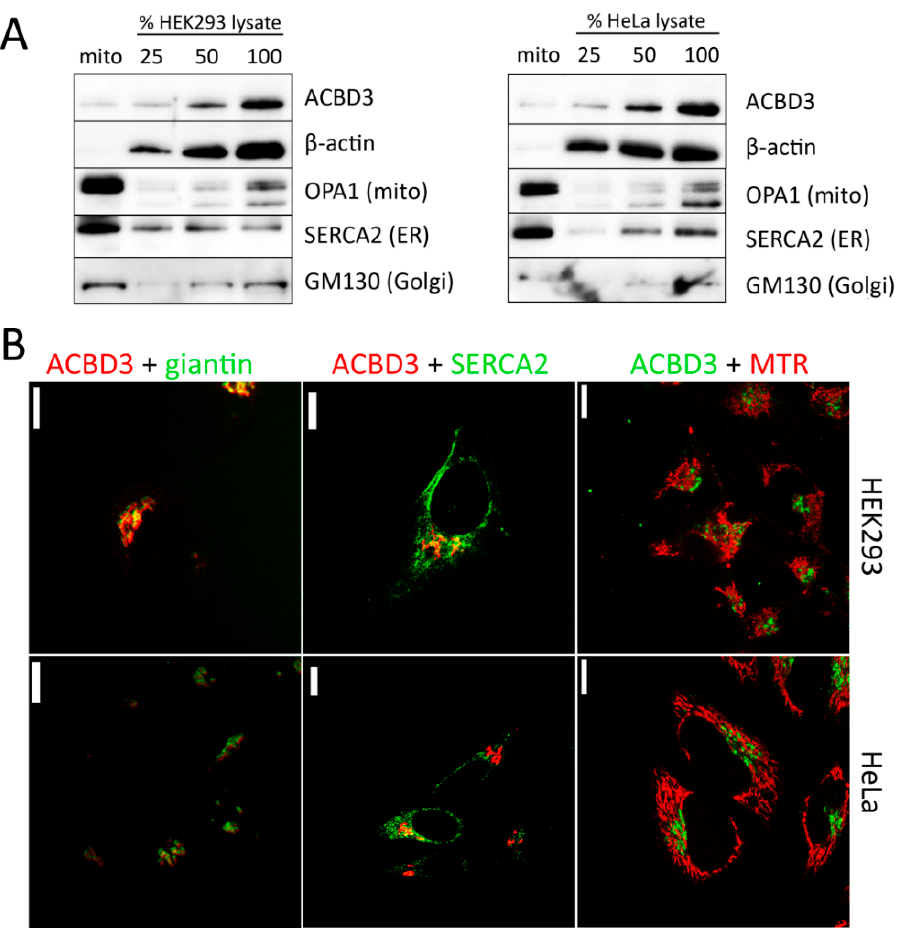
Figure 1. Localization of ACBD3 protein in HEK293 and HeLa WT cells. ( A ) Characterization of mitochondrial fraction and whole cell lysate by SDS-PAGE/WB. The mitochondrial fraction reveals only a slight signal of ACBD3, but the mitochondrial fraction is enriched by endoplasmic reticulum (ER, SERCA2 antibody) and also a slight signal of Golgi (GM130). ( B ) Confocal microscopy of HEK293 WT and HeLa WT cells. The cells were immunolabeled by ACBD3 antibody and, where indicated, by specific markers for Golgi (giantin), ER (SERCA2), and mitochondria (MitoTracker Red (MTR)). Overlay of signals was found only between ACBD3 and giantin (Golgi). Scale bar 10 µm.